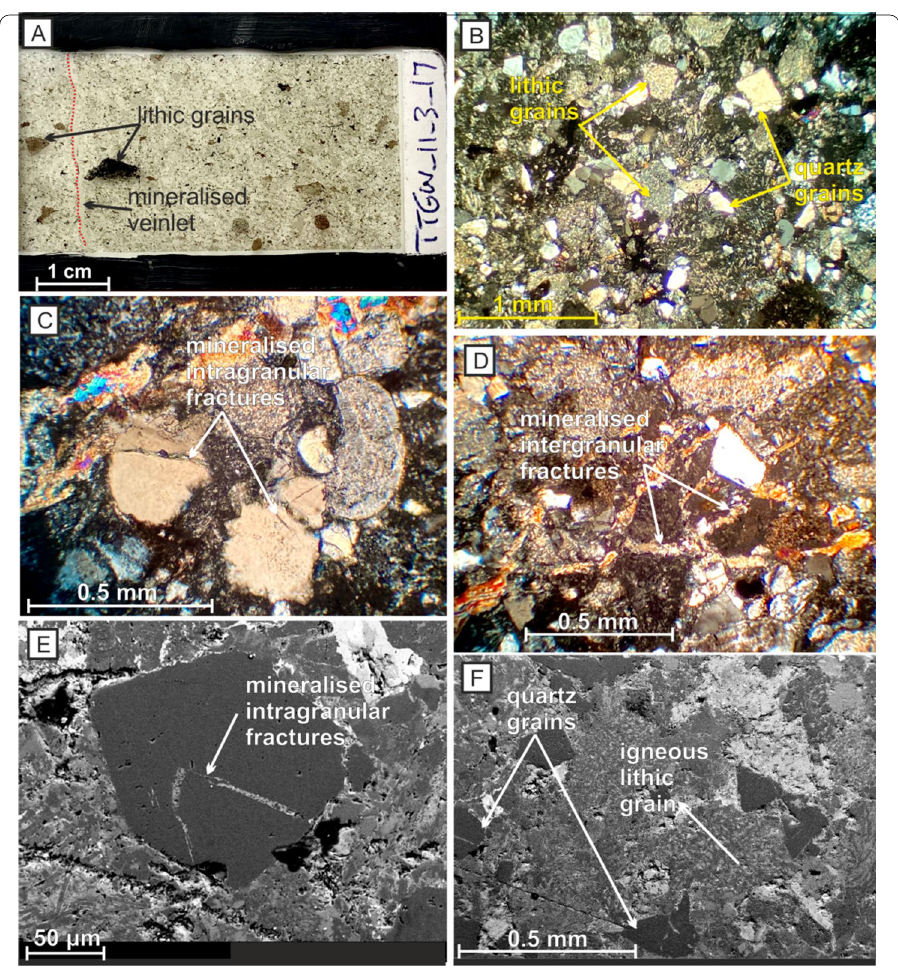
Fig. 3 A photograph of thin section of sample TTGW_11_3_17 showing grain size variation and mineralized veinlets (red line); B photomicrograph (XP; TTGW_11_3_17) showing typical grain size and texture of Waipapa basement greywacke; C photomicrograph (XP; TTGW_11_3_17) showing mineralized intragranular fractures in quartz grains; D photomicrograph (XP; TTGW_11_3_17) showing mineralized intergranular veinlets in Waipapa greywacke; E SEM backscatter image (TTGW_11_3_17) showing mineralized intragranular fractures within a quartz grain; F SEM backscatter image (TTGW_11_3_17) showing typical grain sizes and textures of Waipapa greywacke basement and the igneous textures noted in lithic grains. Qz